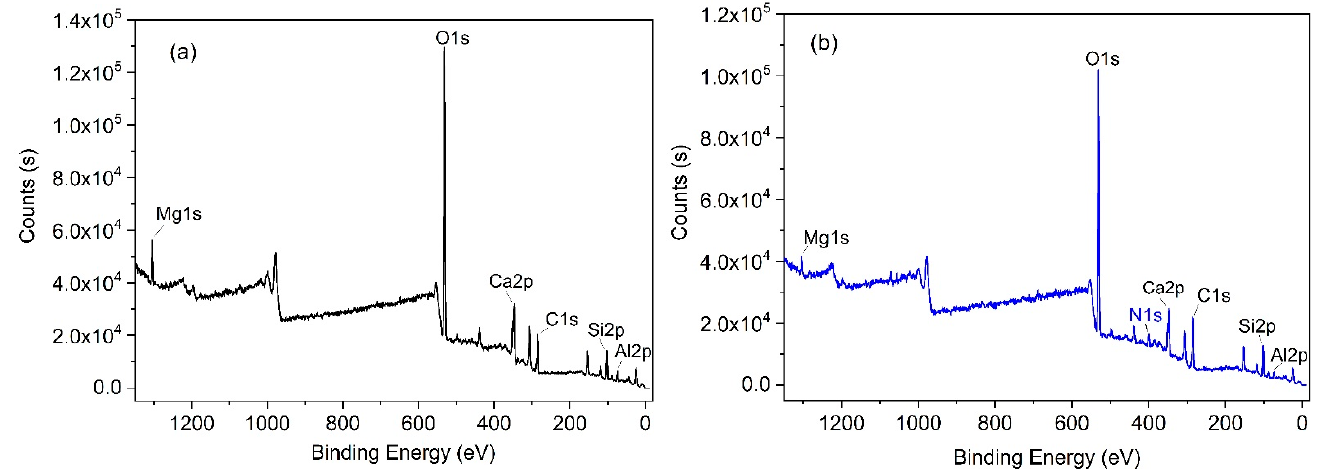
Figure 2. Solid state 29 Si ( a ) and 27 Al ( b ) MAS NMR spectra of pristine slag.